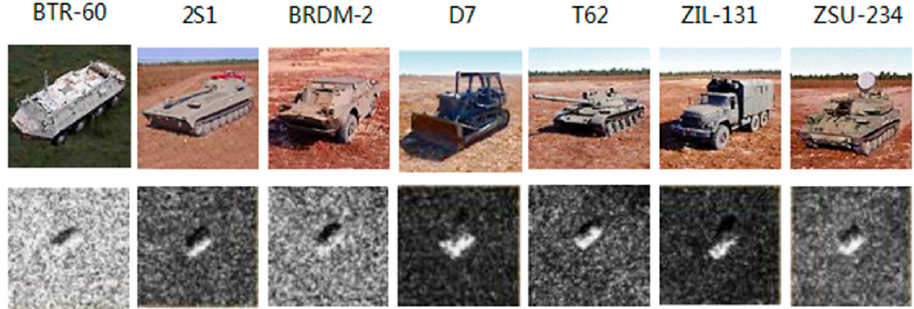
Figure 3. Military targets of the mixed target dataset.